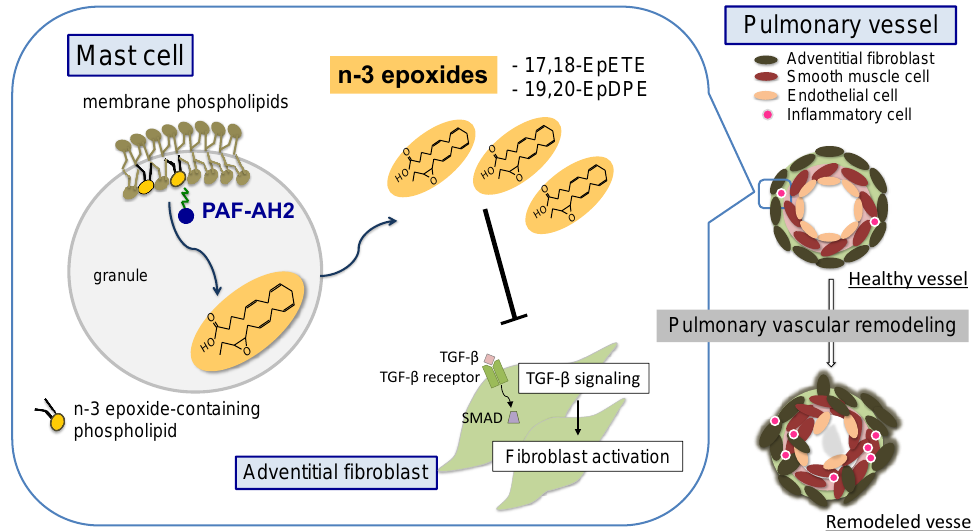
Figure 2. A novel mechanism of pulmonary vascular remodeling by n-3 epoxides. Mast cells- derived n-3 epoxides produced by PAF-AH2 regulate pulmonary vascular remodeling through inhibiting abnormal activation of adventitial fibroblasts. PAF-AH2, type II platelet activating factor acetylhydrolase.